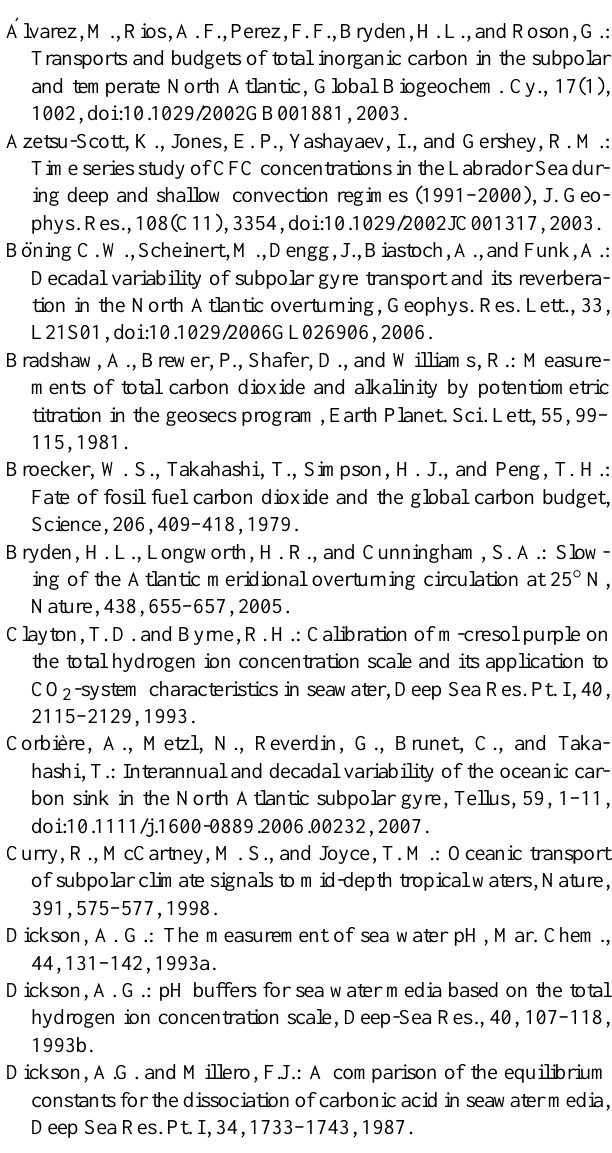
Table B2. Comparison of results from two independent C ant es- timation methods. Overall, there is no statistically significant dif- ference between the results derived from the TrOCA or the ϕ C ◦